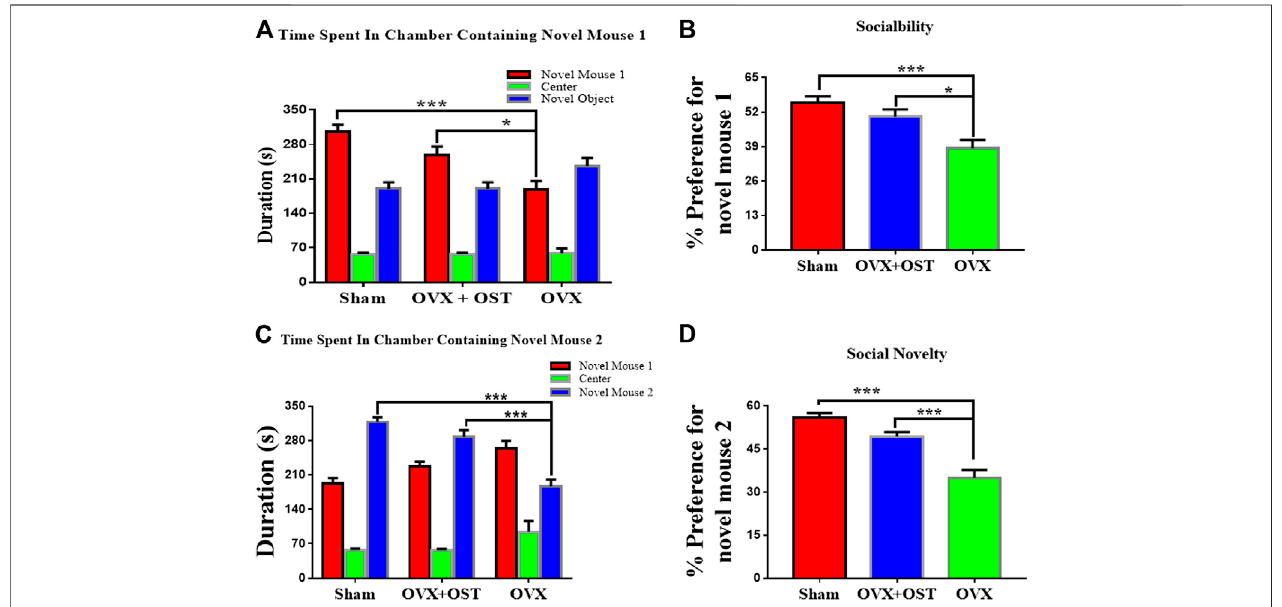
FIGURE 4 | Effects of OST on OVX mice in the three-chamber social interaction test. Mice in the OVX group spent less time interacting with the novel mouse 1 (A) and 2 (C) , thereby exhibited a decrease in sociability (B) and social novelty (D) , whereas the mice treated with OST reversed the OVX-mediated decrease. Data are represented as mean ± SEM ( n (cid:1) 15). * p < 0.05; ** p < 0.01; *** p < 0.001.